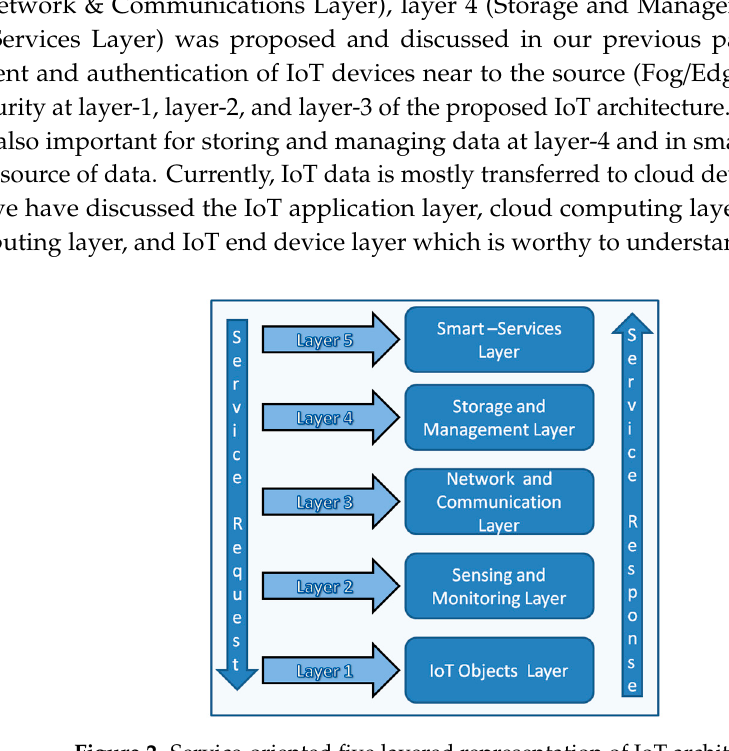
Figure 2. Service-oriented five layered representation of IoT architecture.